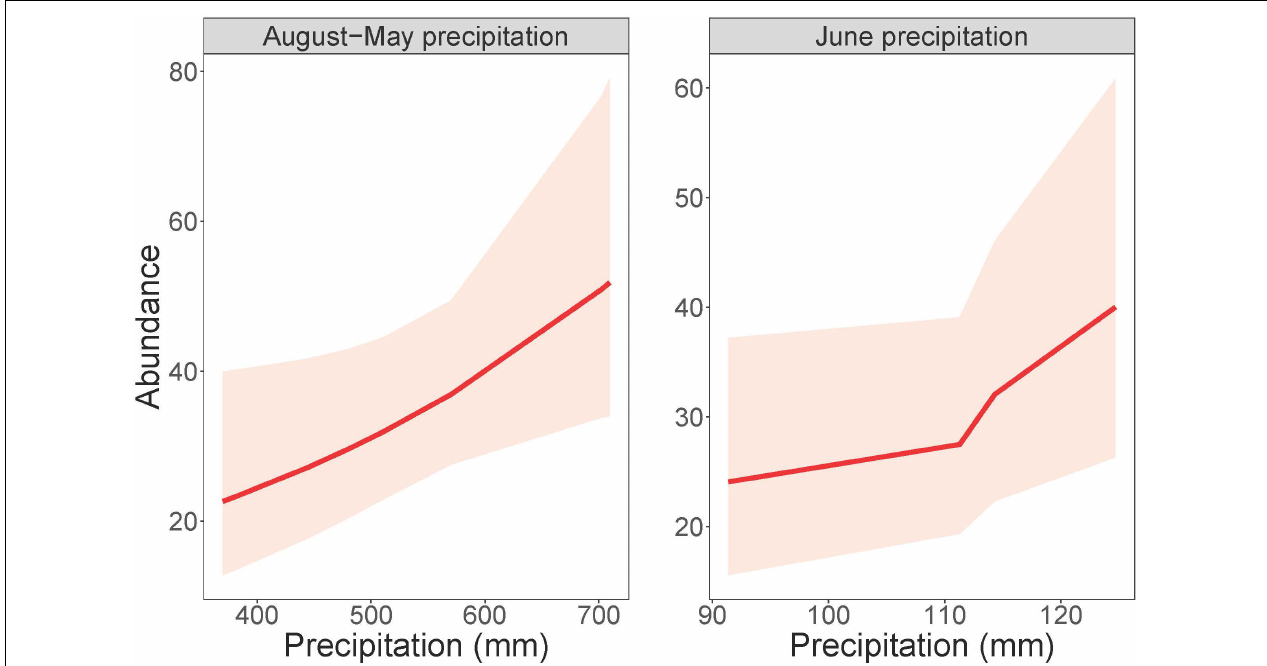
FIGURE 4 | Cowbird abundance in response to precipitation during both the non-breeding season (August-May) and June. Total August-May precipitation (left) and total June precipitation (right) plotted against numbers of individual adult birds, within 95% confidence intervals.